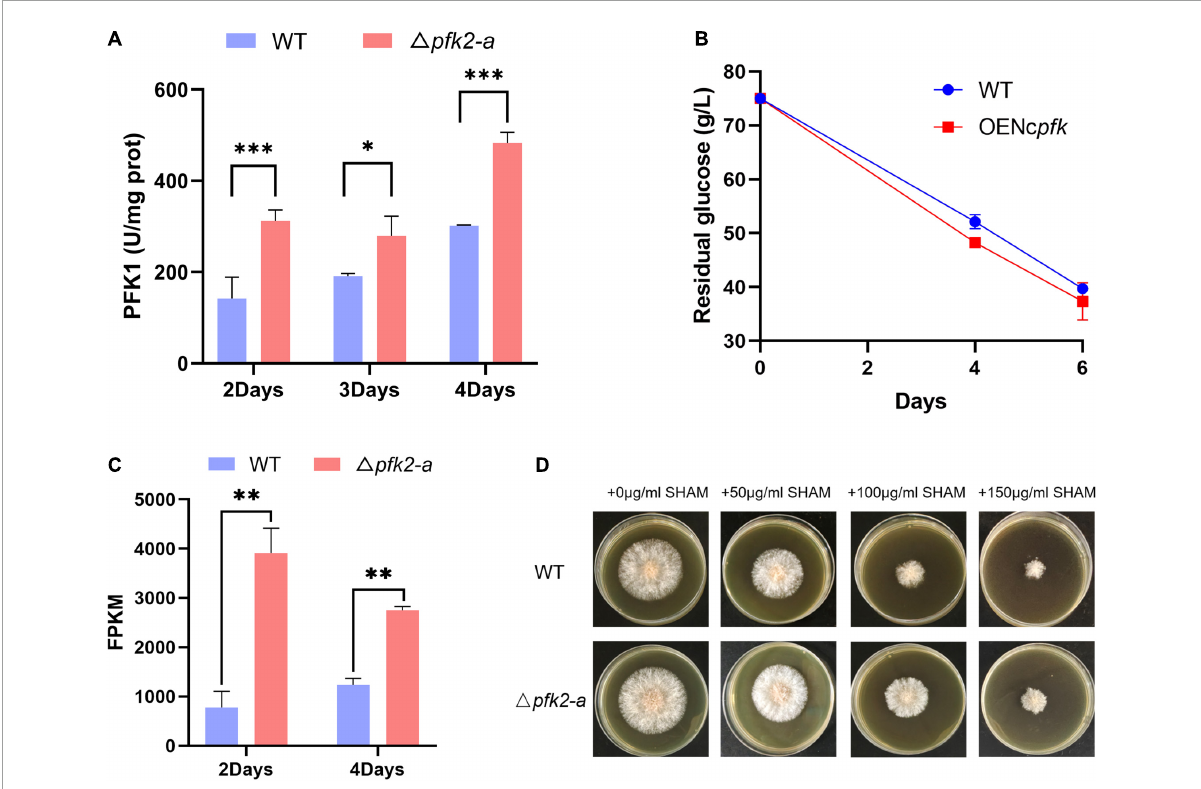
FIGURE4 Regulatory role of pfk2-a in the metabolism of Myceliophthora thermophila . (A) PFK1 activity of WT and (cid:49) pfk2-a mutants at 2–4 days of mycelial culture. (B) Glucose consumption of the WT and OE Ncpfk strains in glucose medium. (C) Comparison of the fragments per kilobase of exon model per million mapped fragments (FPKM) of aox in the WT and (cid:49) pfk2-a mutant strains at 2 and 4 days. (D) Comparative expression of AOX in the WT and (cid:49) pfk2-a mutant strains derived from testing the resistance to SHAM, a specific inhibitor of the alternative respiratory pathway. Stronger SHAM resistance was considered an indicator of higher AOX expression. ∗ p < 0.05; ∗∗ p < 0.01 and ∗∗∗ p <